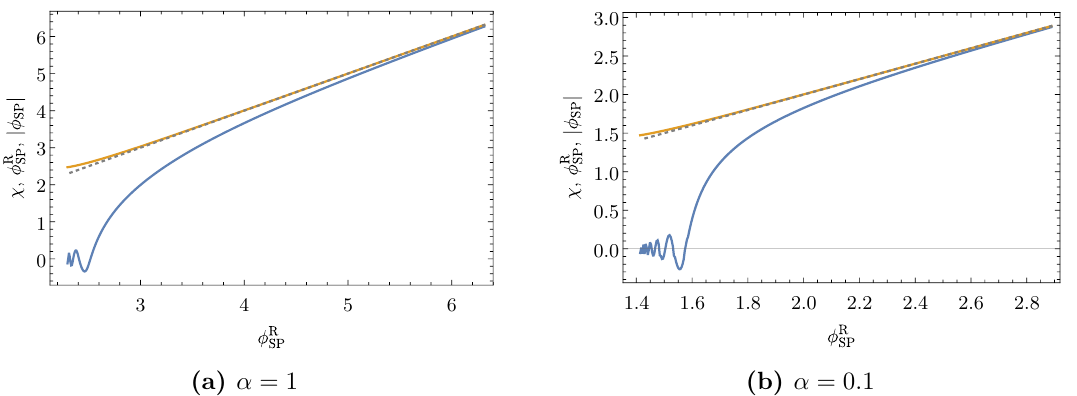
Figure 4. The relation between the scalar (cid:12)eld values at the South Pole ( (cid:28) = 0 at which a = 0 and (cid:30) = (cid:30) SP ) and at the nucleation point (at which (cid:30) = (cid:31) and a = b ). The blue solid (bottom) lines show (cid:31) , and the orange solid (top) lines show j (cid:30) SP j . To guide the eyes, the line of (cid:30) R as the horizontal axis) is shown as the gray dotted lines. The value of b is taken as b =